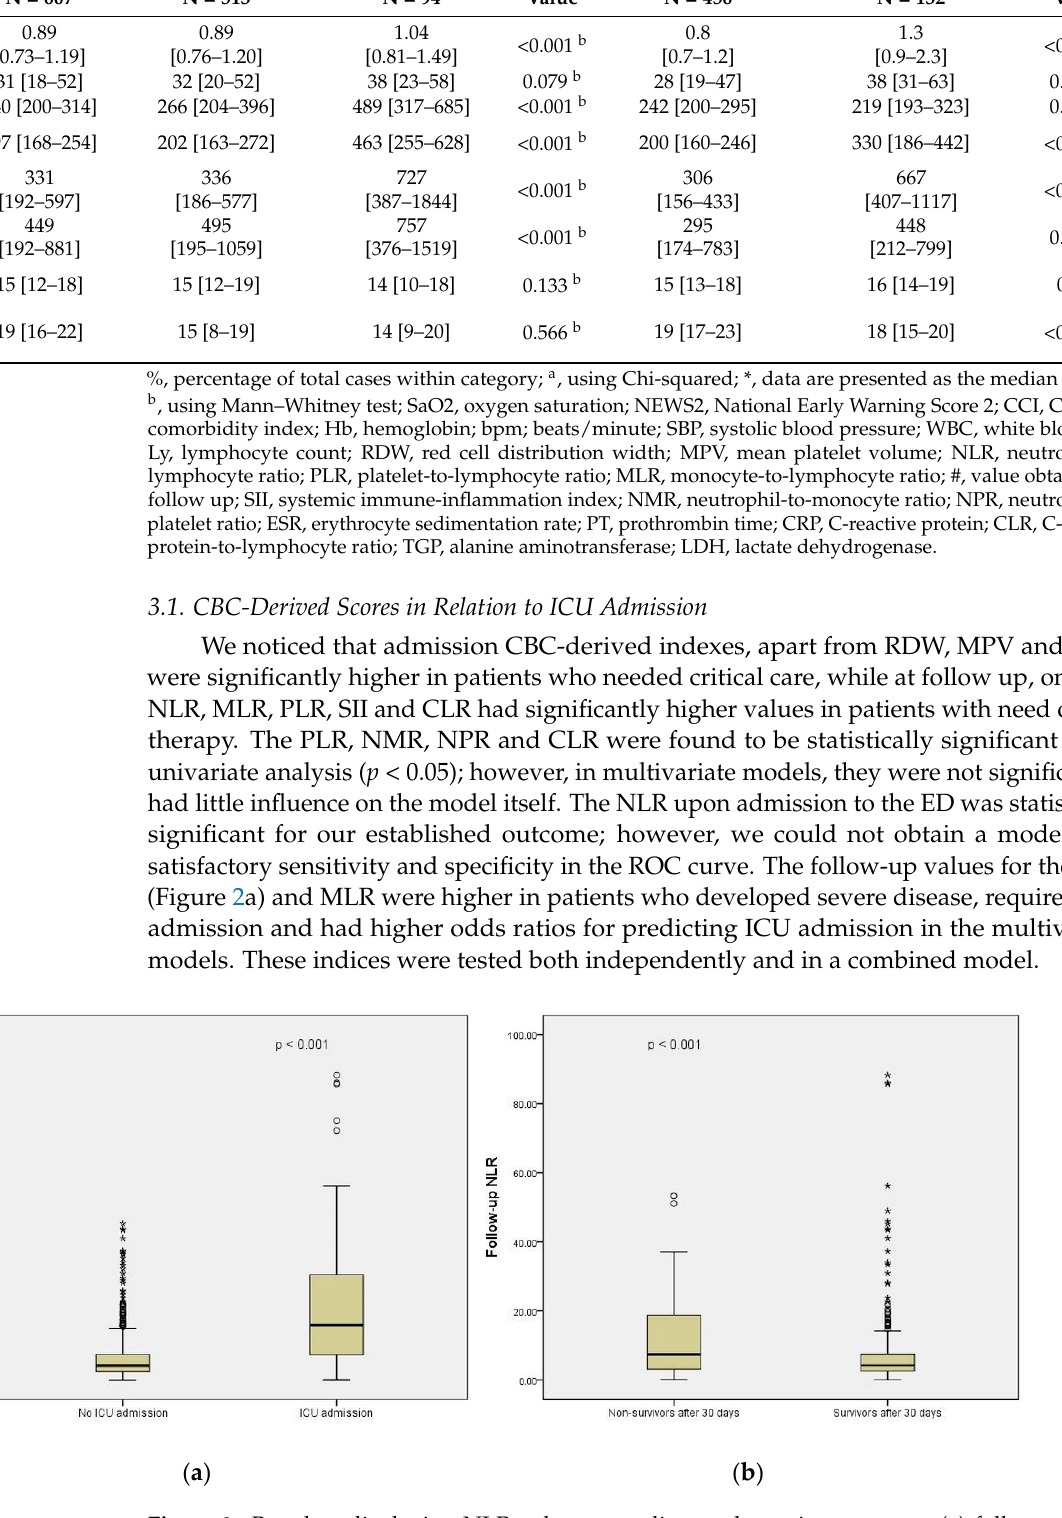
Figure 2. Boxplots displaying NLR values according to the main outcomes: ( a ) follow-up NLR was significantly higher in patients admitted to ICU; ( b ) follow-up NLR was significantly higher in non-survivors 30 days post-discharge; ° represent outliers; * represent extreme values.